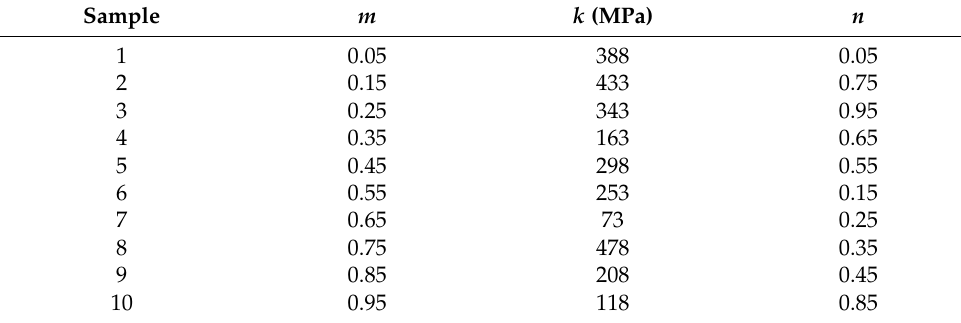
Table 1. The list of all samples investigated for the